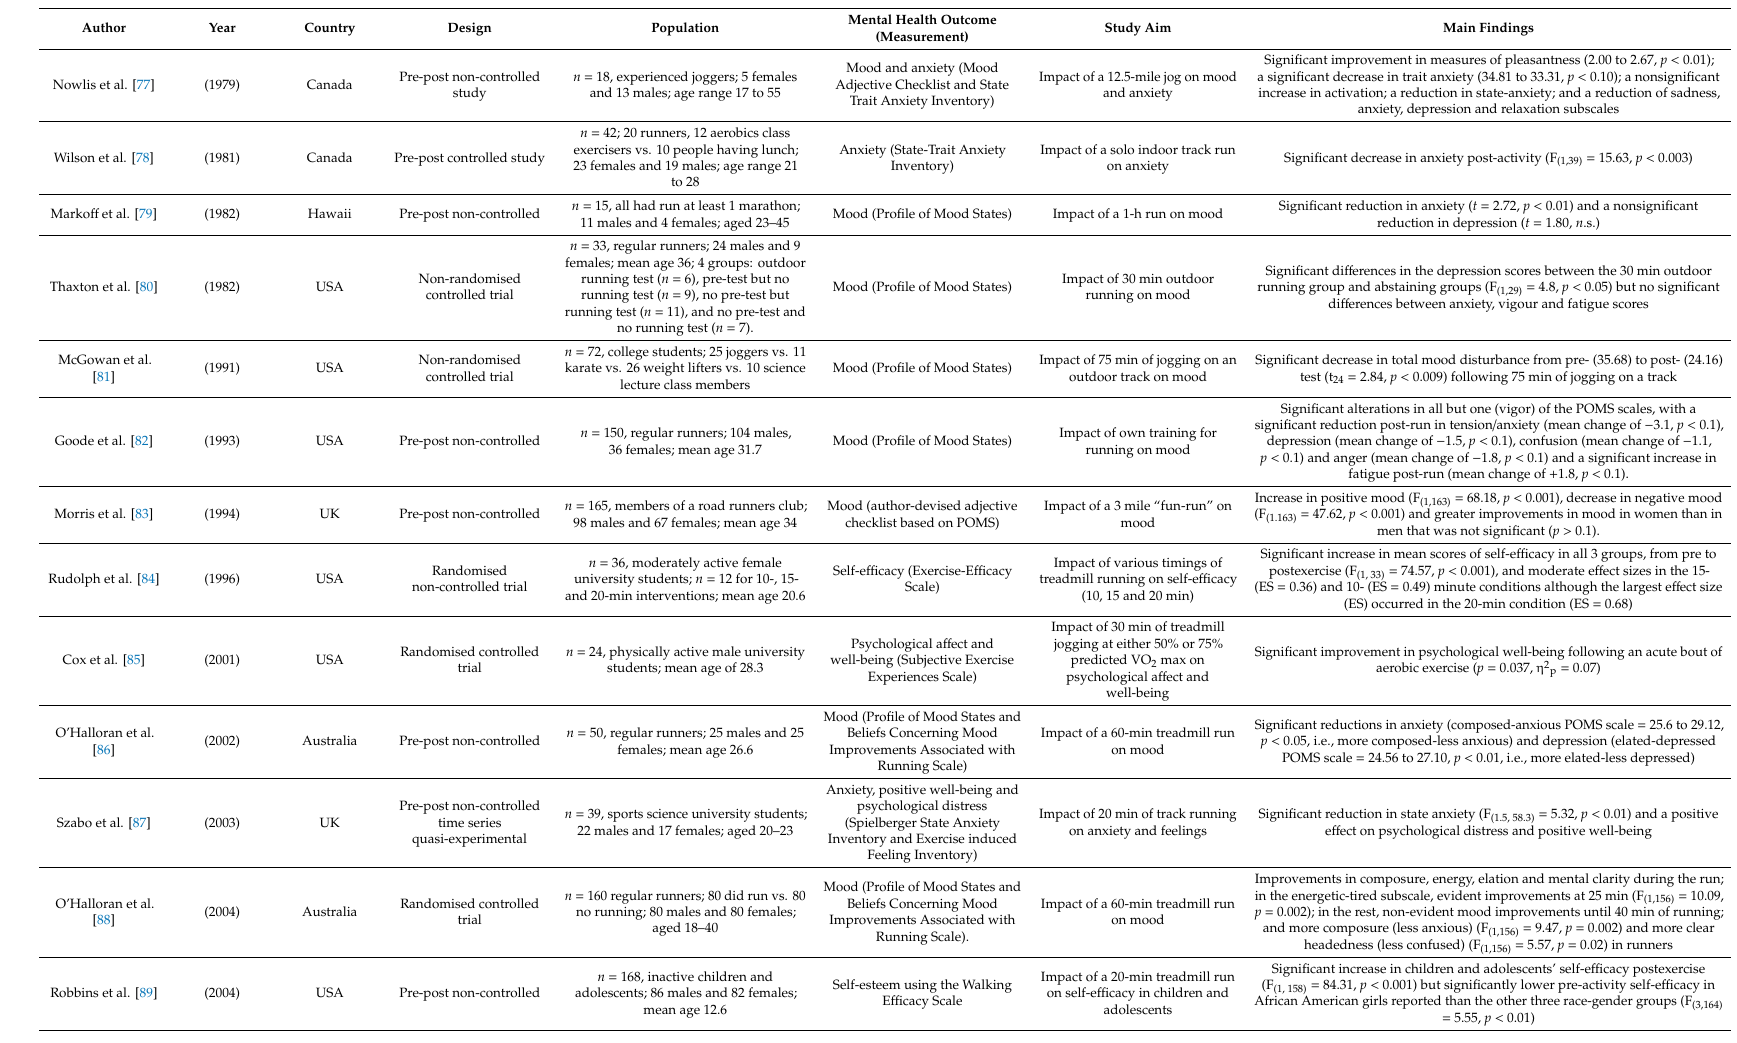
Table 3. Summary of data extraction from the 23 single-bout